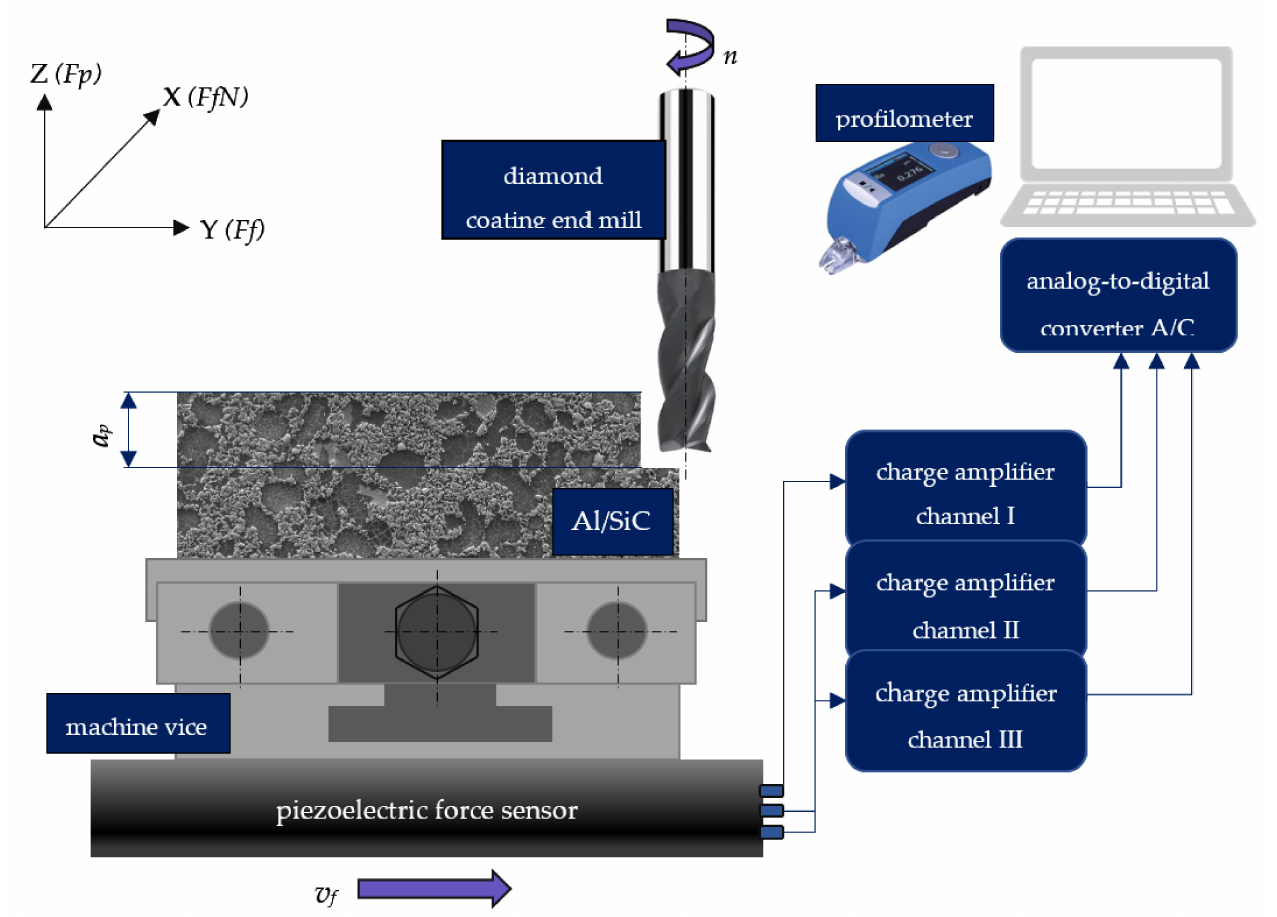
Figure 2. Schematic of the experimental set up.